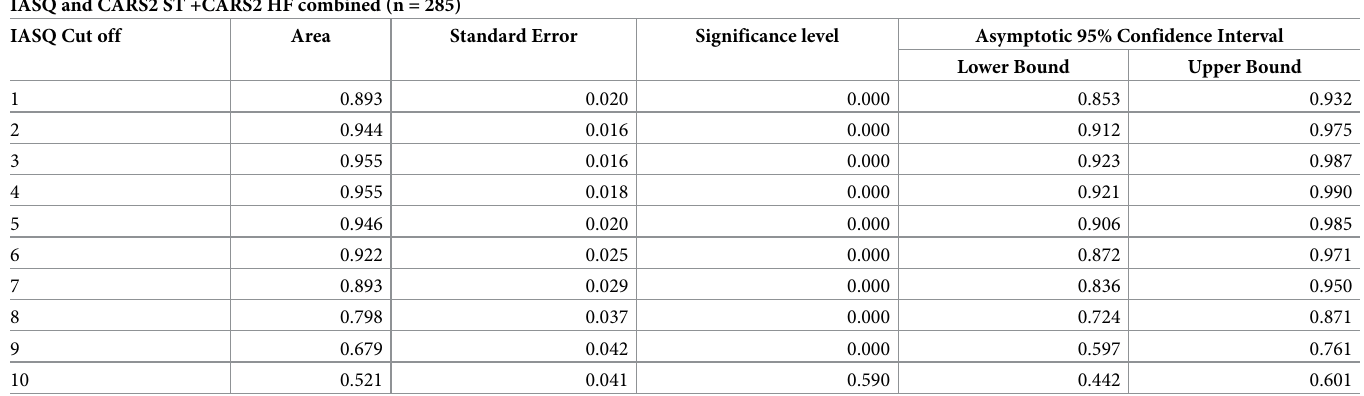
Table 3. Results of ROC curve analysis.